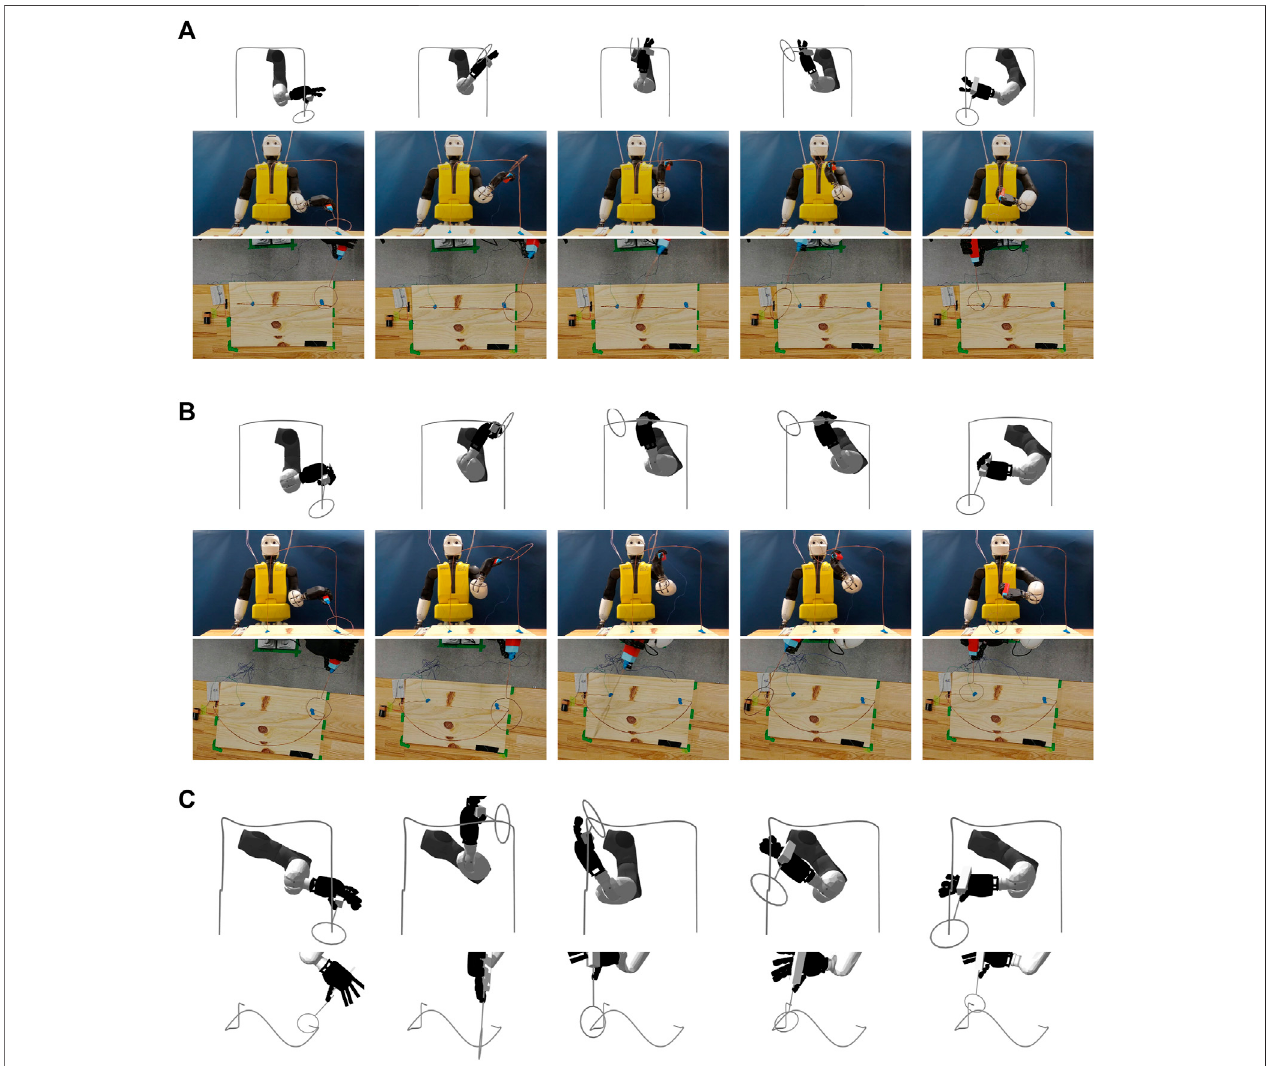
FIGURE 2 | (A) Frames from the optimized trajectory on Obstacle-A executed by the REEM-C arm in the Gazebo simulator (top row) and the same trajectory executedonthefullREEM-Chumanoidhardwarefromafrontview(middlerow)andtop-downview(bottomrow). (B) FramesfromtheoptimizedtrajectoryonObstacle- B executed by the REEM-C arm in the Gazebo simulator (top row) and the same trajectory executed on the full REEM-C humanoid hardware from a front view (middle row)andtop-downview(bottomrow). (C) FramesfromtheoptimizedtrajectoryonObstacle-CexecutedbytheREEM-CarmintheGazebosimulator(toprow)and the same trajectory executed on the full REEM-C humanoid in the Gazebo simulator from a top view showing the sine shape on the top portion of the wireframe (bottom row).